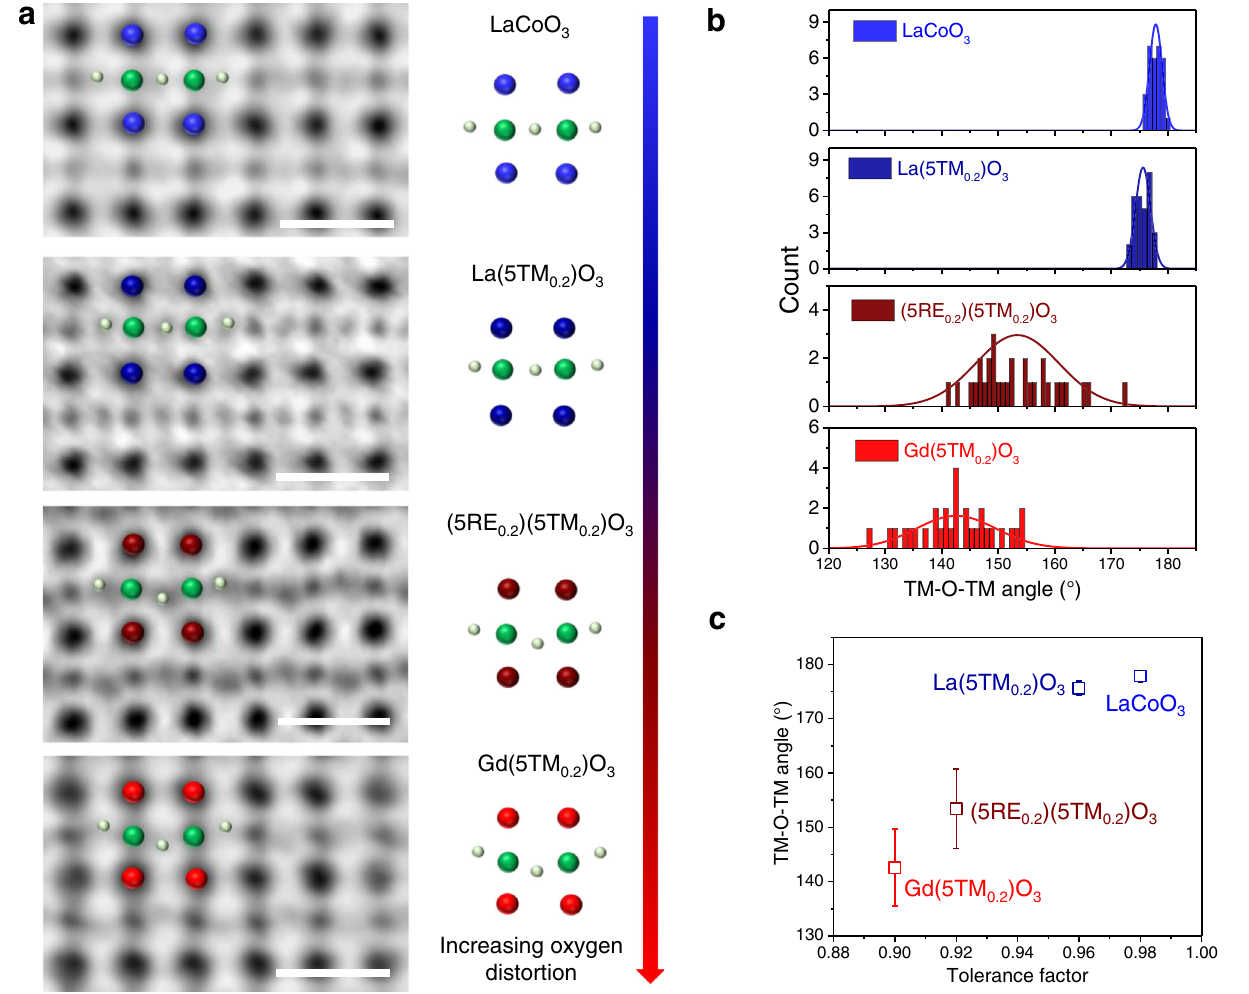
Fig. 4 Oxygen tilt of the four samples. a ABF images of LaCoO 3 , La(5TM 0.2 )O 3 , (5RE 0.2 )(5TM 0.2 )O 3 , and Gd(5TM 0.2 )O 3 , respectively, showing the TM – O – TM angle in their lattice structures. The green and silver spheres representing the B-site atoms and oxygen atoms, respectively. While the blue, dark blue, dark red and red spheres representing the A-site atoms in the four samples, respectively. Scale bar is 0.5 nm. b Distribution of the TM – O – TM angle in the four samples. c The relationship between TM – O – TM angle and tolerance factor. Data are presented as means of ±SD of the distribution of TM – O – TM